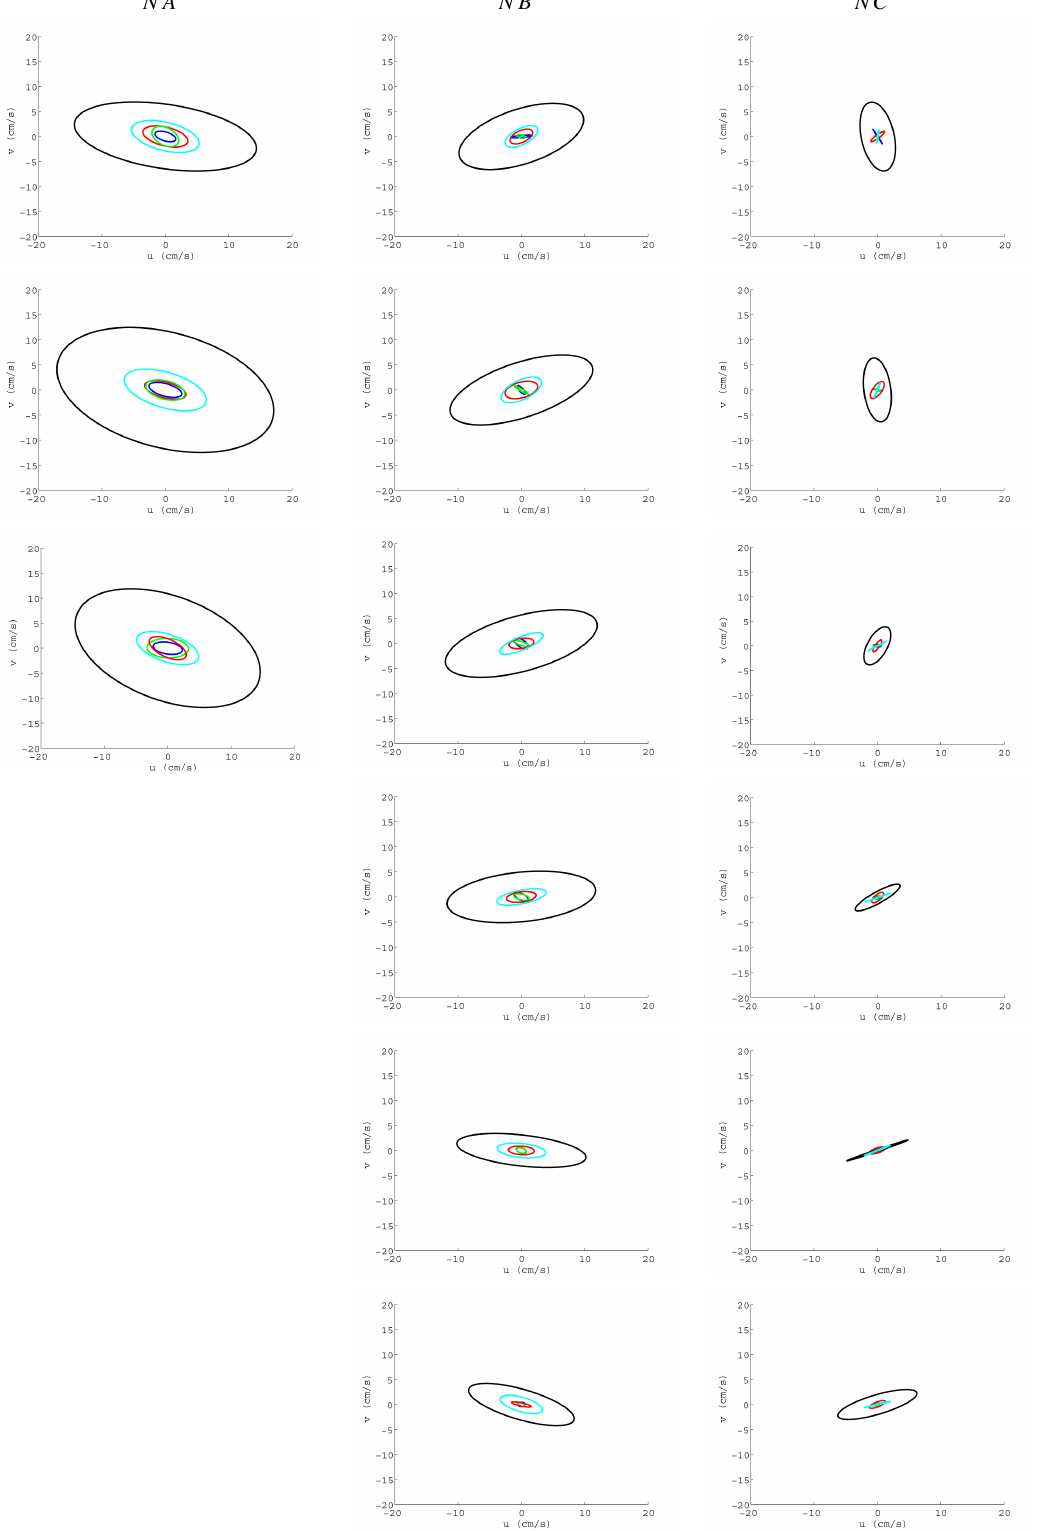
Fig. 4. Variation of tidal constituents ( M 2 black, S 2 cyan, N 2 red, O 1 blue and K 1 green) with depth (from top to bottom at about 220, 320, 420, 520, 620, and 720m depth) and space in the section north of the